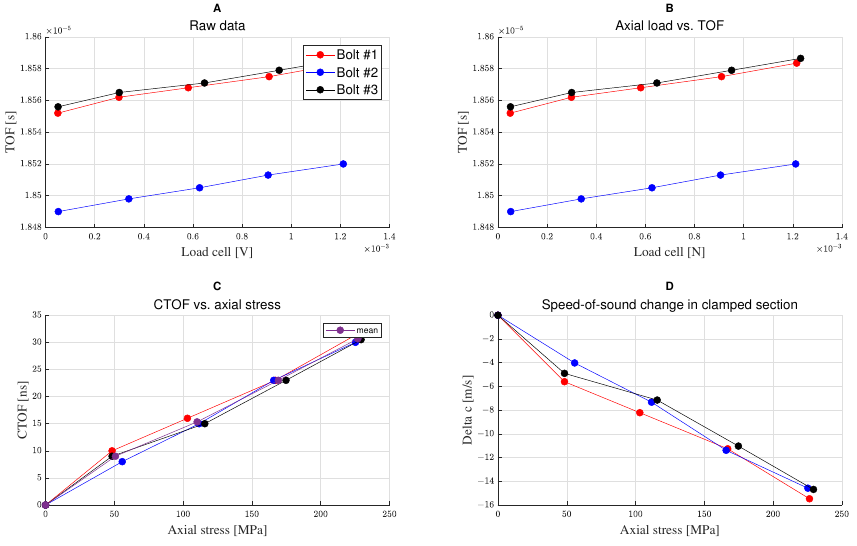
Figure 16. ( A ) Raw data measured from the load cell. ( B ) TOF of the ultrasonic wave vs bolt axial load measured by the load cell. ( C ) A linear relationship between the CTOF and the “pre-tensioning” bolt axial stress. The three data sets’ mean value curve are represented. ( D ) A linear relationship between the change in the ultrasonic wave propagation velocity and the “pre-tensioning” bolt axial